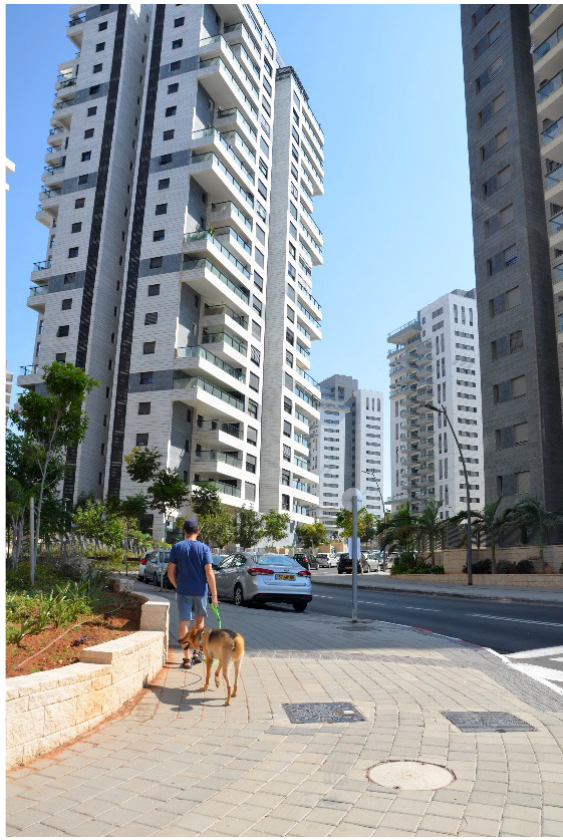
Figure 10. Public spaces of a new neighborhood in Rosh HaAyin. An example for a street without interest and uses other than